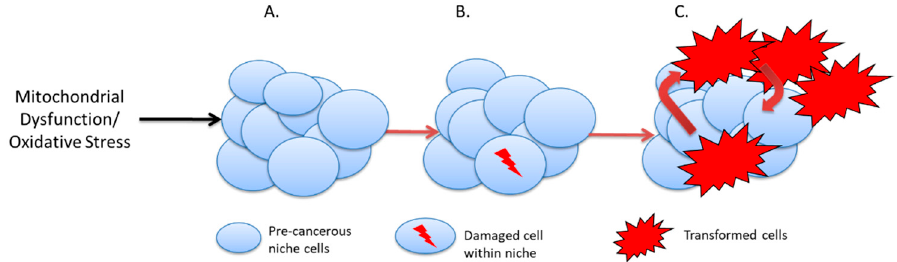
Figure 2. Cancer initiation in the pre-cancer niche. ( A ). Cells within the precancerous niche un- dergo telomere attrition or suffer genetic damage due to elevated oxidative stress. ( B ). Telomere crisis or further DNA damage may lead to loss of heterozygosity and malignant transformation. ( C ). Malignant cells in contact with chronically inflamed pre-cancerous niches proliferate and initiate tumour growth.